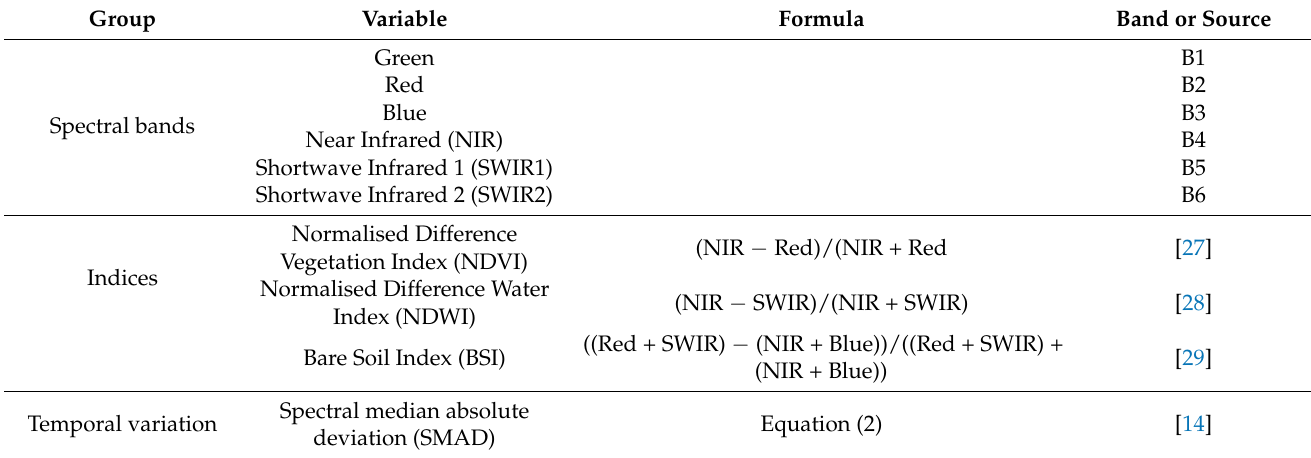
Table 3. Variables used for irrigated land use classification for three irrigation schemes in